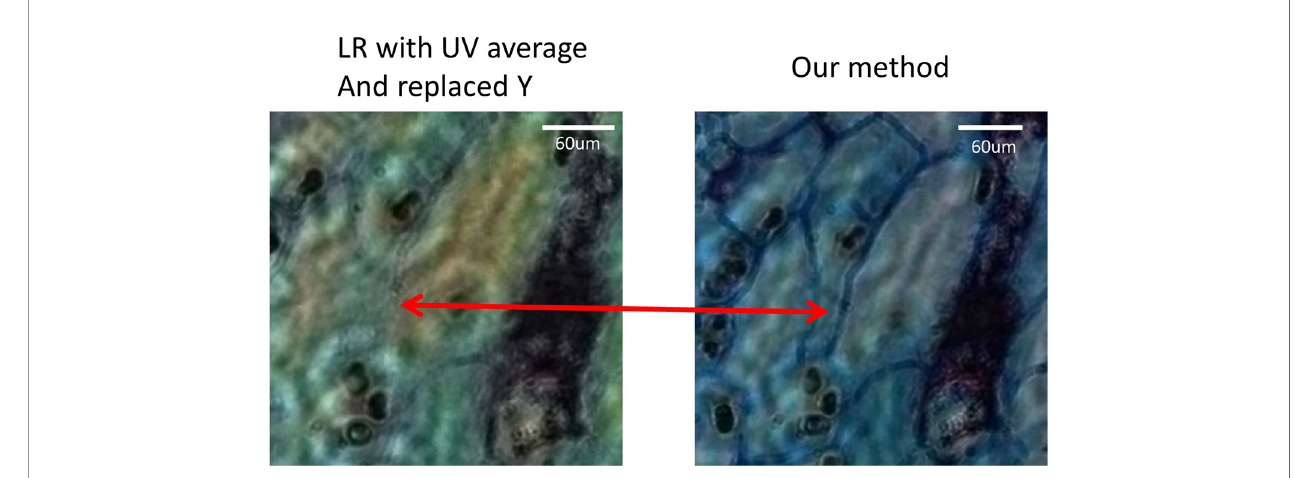
FIGURE 6 | The image of the lotus root cross section proves that only a single band of pixel super-resolution image replaces the Y component, resulting in the loss of certain